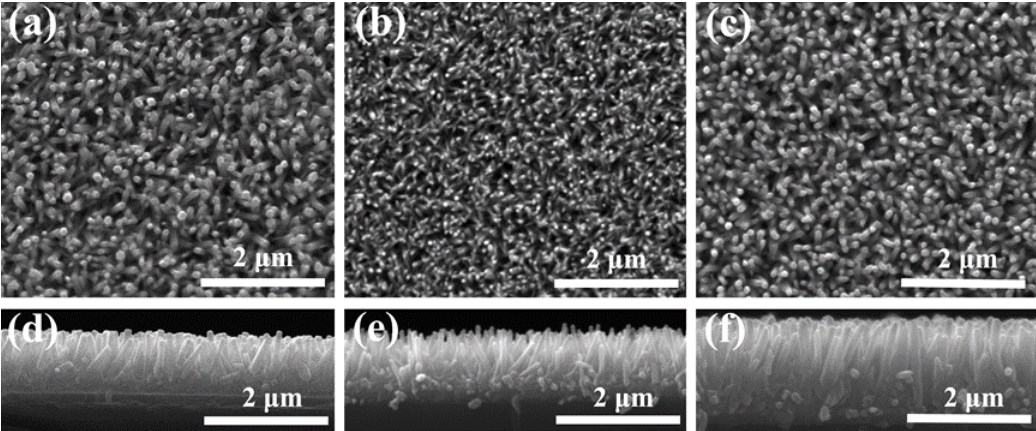
Figure 1. SEM images—plane view and cross section- of the ZnO nanorods grown in 0.5% formamide for each of the three procedures A ( a , d ), B ( b , e ) and C ( c , f ) respectively.